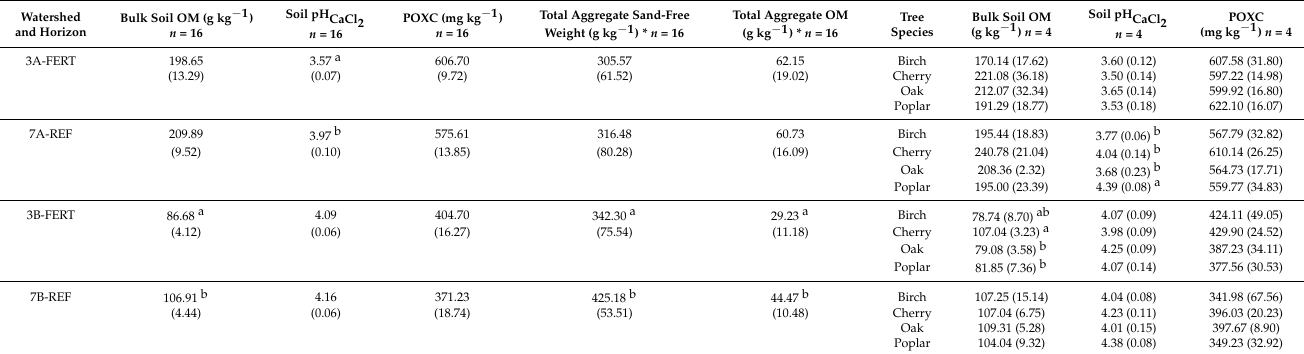
Table 1. Mean bulk soil organic matter (OM), soil pH CaCl , permanganate oxidizable carbon (POXC), and total aggregate 2 weight and OM from each watershed and beneath four tree species: values indicate mean ( ± standard error). Values with different letters indicate statistically significant differences according to Wilcoxon pairwise means separation ( p < 0.05). Significance is denoted between watersheds within the respective horizons and among species within the respective watershed and horizon. * Values represent sum of aggregate weight and OM in size classes between 53 and 2000 µ m,